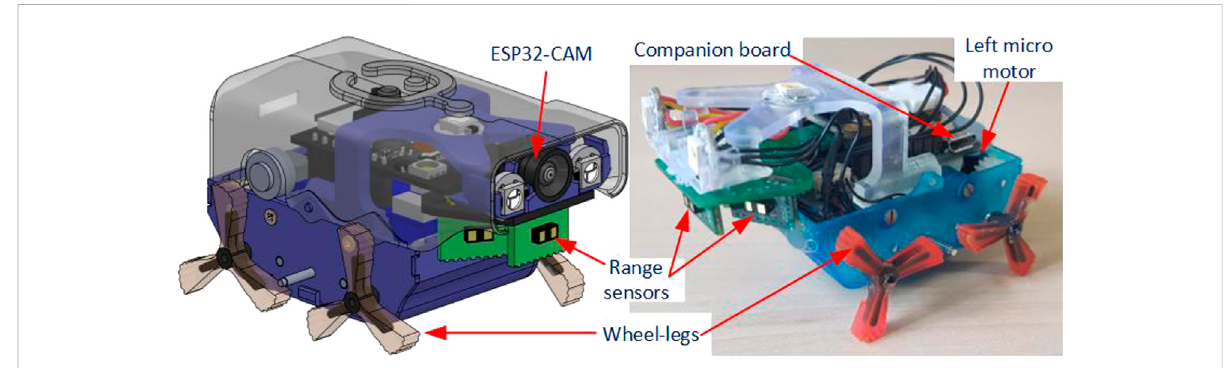
FIGURE 1 Robot CAD model and current physical model used in this paper. The main difference between the two models is that the physical robot does not need/equip an ESP32-CAM (development board for streaming camera video via WiFi) and has a simpli fi ed upper shell (for convenient downloading of the program for